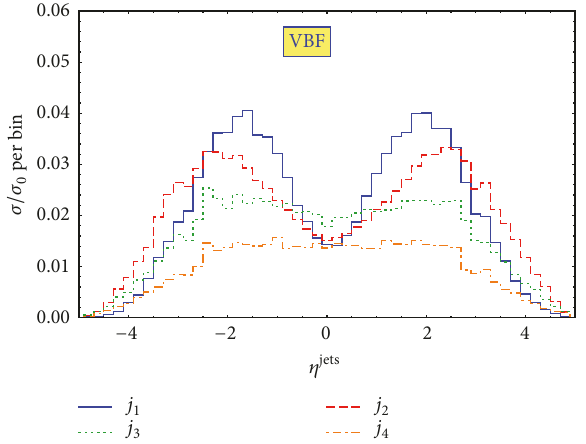
Figure 19: Rapidity distributions of the associated jets in the tri- lepton mode from VBF process.